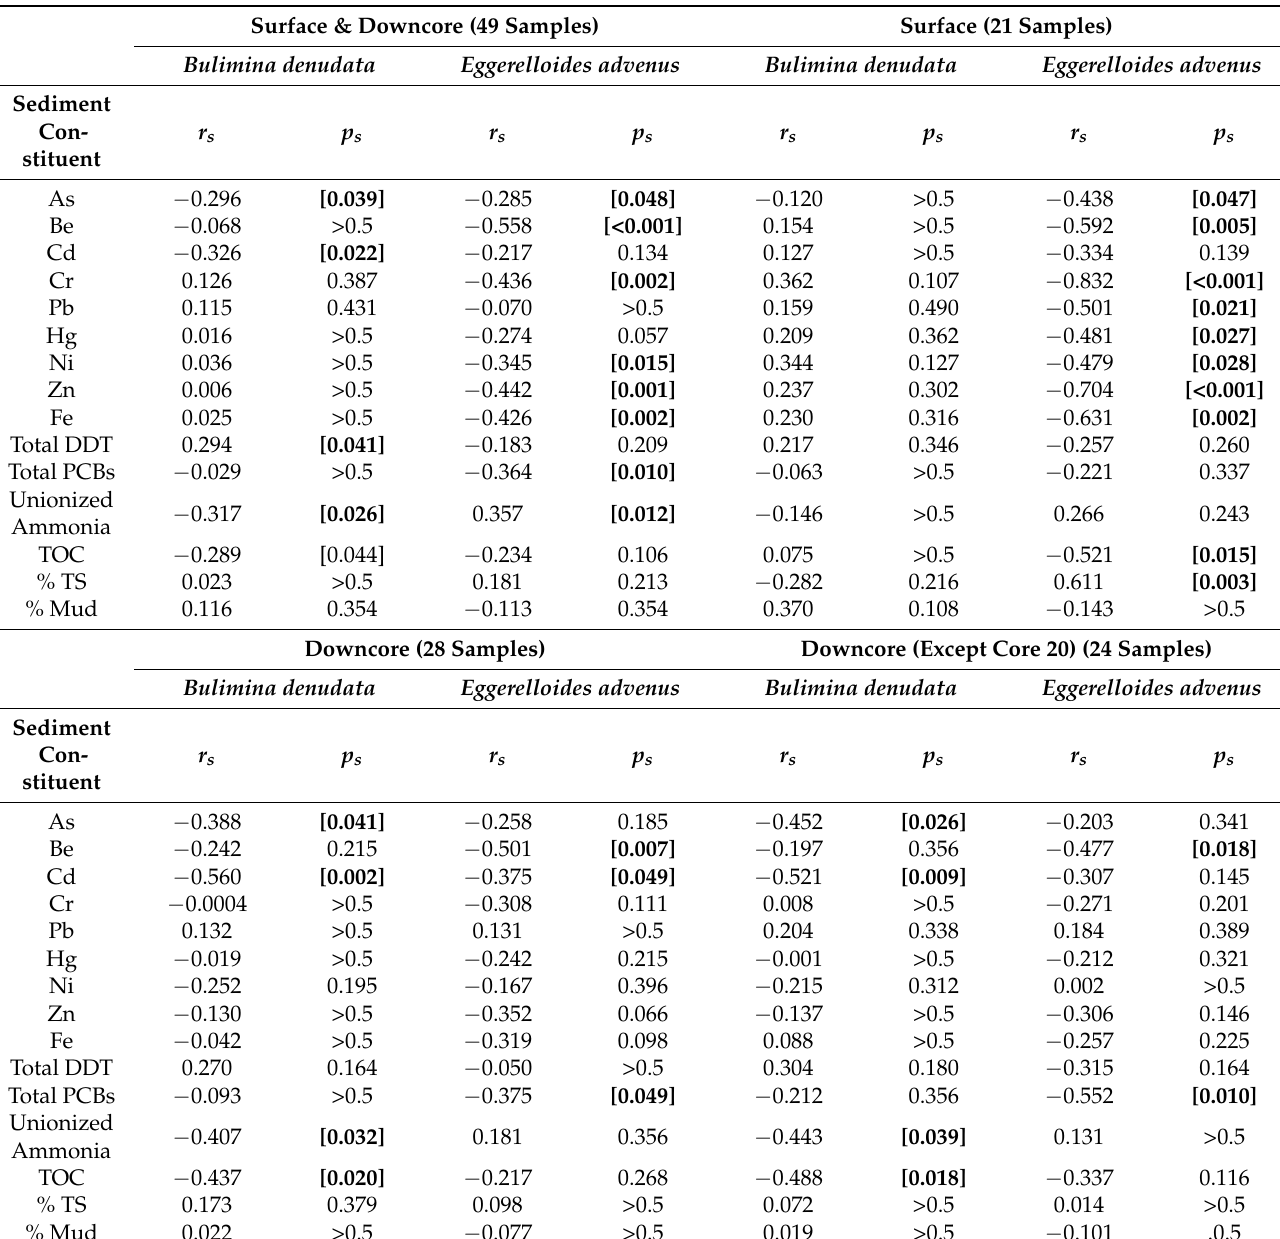
Table 4. Spearman rank correlations for species abundances of Bulimina denudata and Eggerelloides advenus with sediment constituents, including sediment chemistry analytes, TOC, total solids (% TS), and mud content (% mud). Values log transformed and normalized before correlation except for % mud and % TS that needed no transformation. Significant correlations ( p < 0.05) are in square brackets and